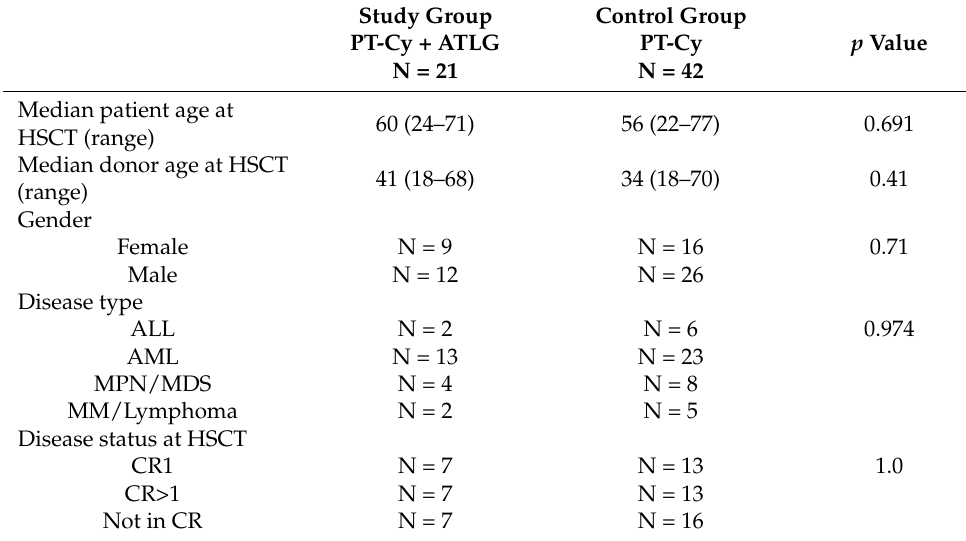
Table 1. Patient and transplant